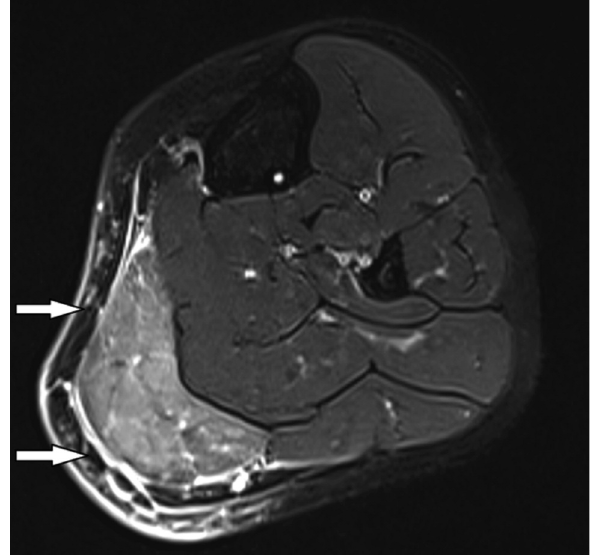
Microscopic findings in x200. Microscopically, the fibers Fig. 2: of gastrocnemius muscle revealed mild size variation and inflammatory cell infiltrations in the endomysium and perivascular area (black arrow). Degeneration and regeneration of muscle fibers associated with interstitial inflammation were also seen. Internal nuclei and features of vasculitis were not